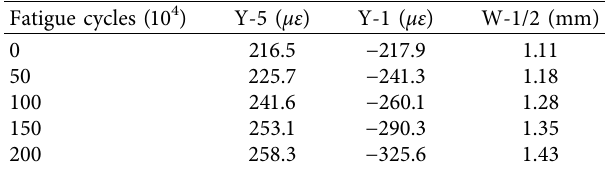
Table 12: The relation between deflections and strain and fatigue loading times for a bonded steel-plate-reinforced plate under the 200kN